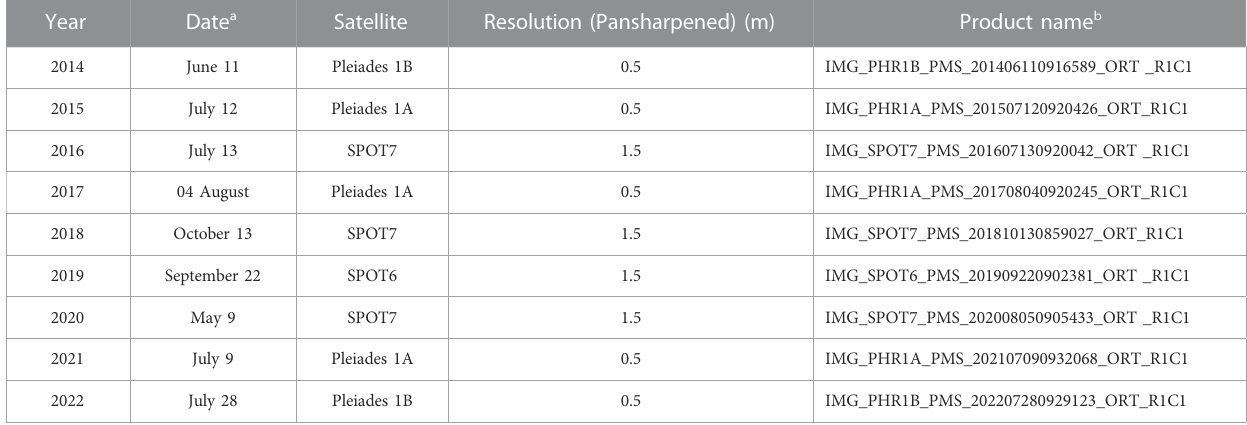
TABLE 1 Speci fi cation of the used Pléiades and SPOT multi-spectral